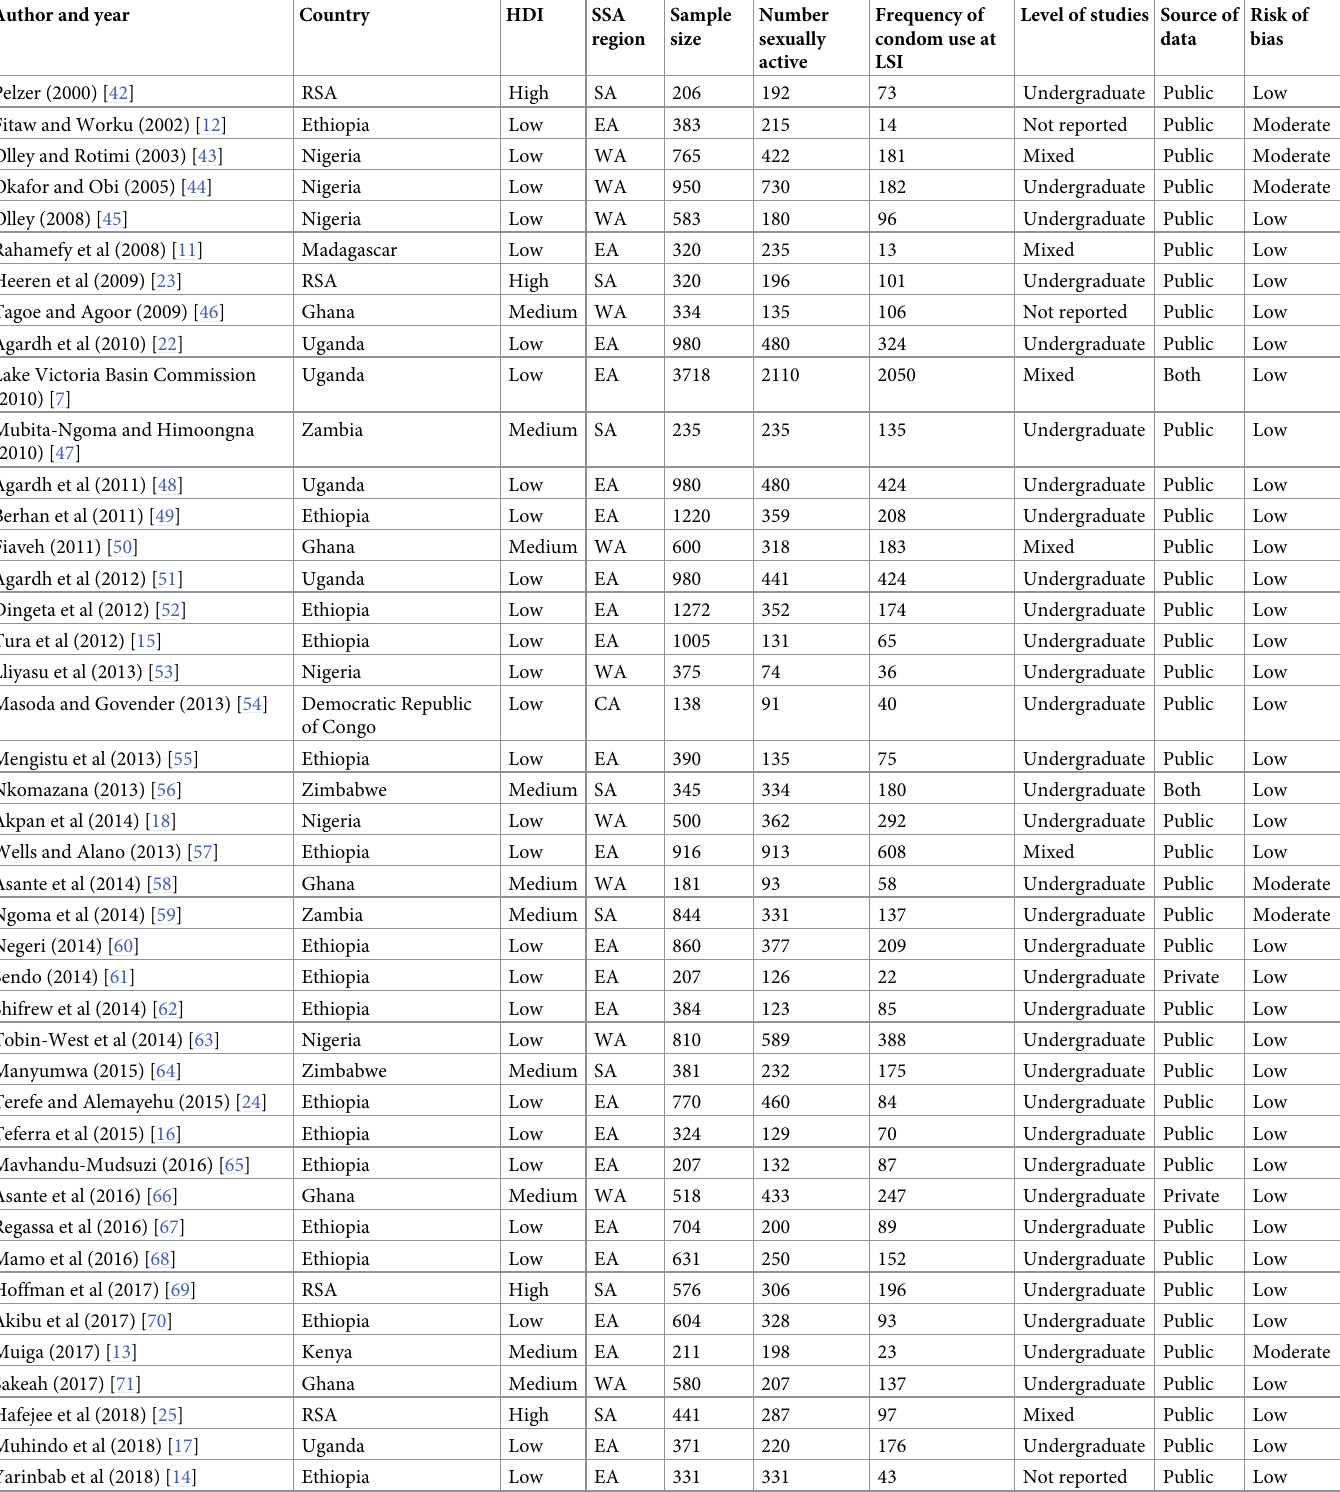
Table 1. Evidence table summarizing the characteristics of included